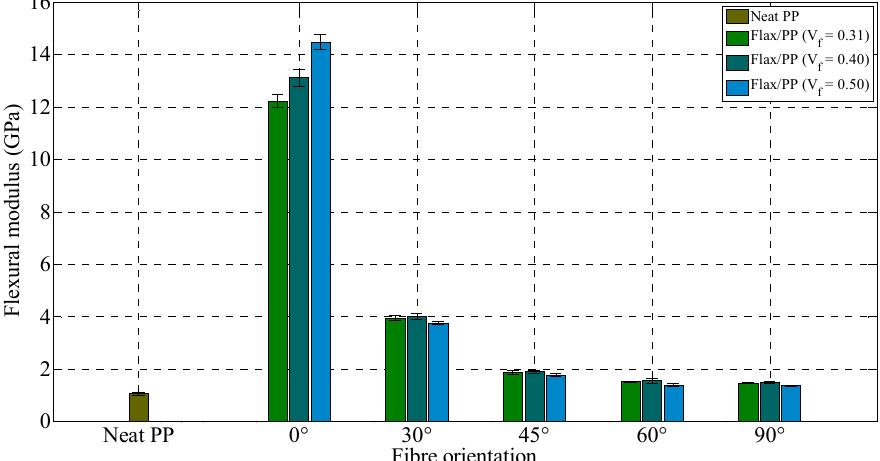
Figure 21. Flexural modulus for neat PP and flax/PP samples of different fibre volume fractions and orientations.